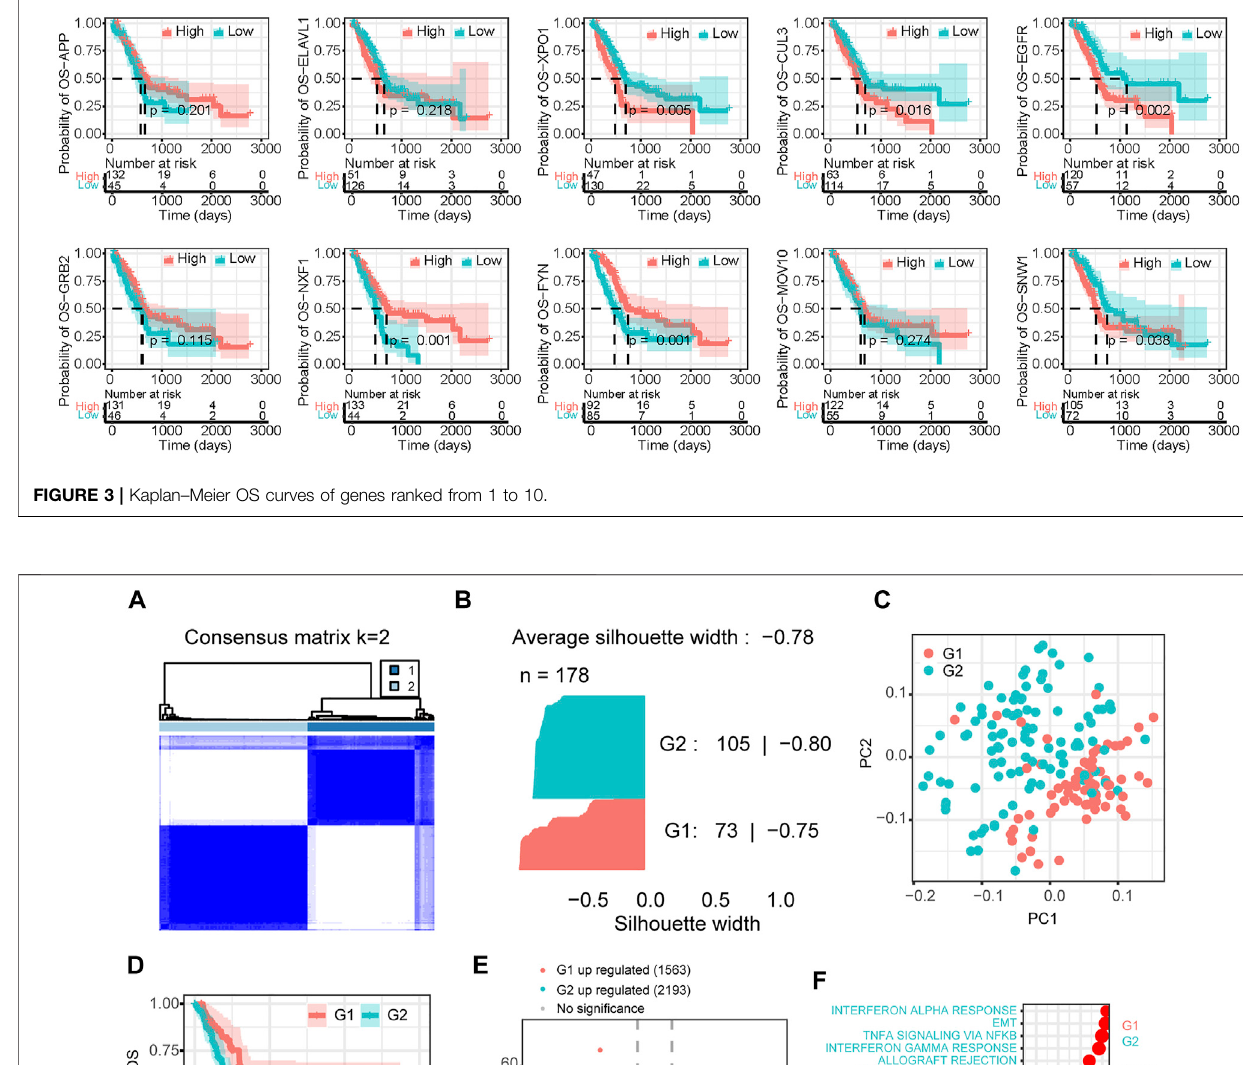
Frontiers in Genetics |